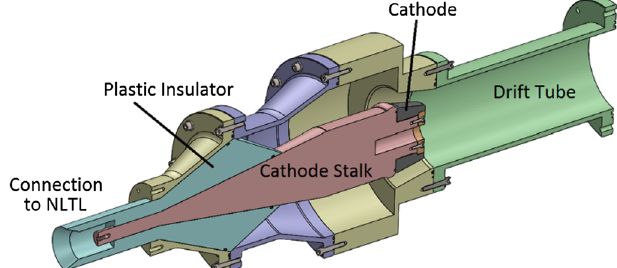
FIG. 3. Machine drawing of the electron beam diode region. A shortened drift tube is depicted to allow for a better aspect ratio to be used in the figure.